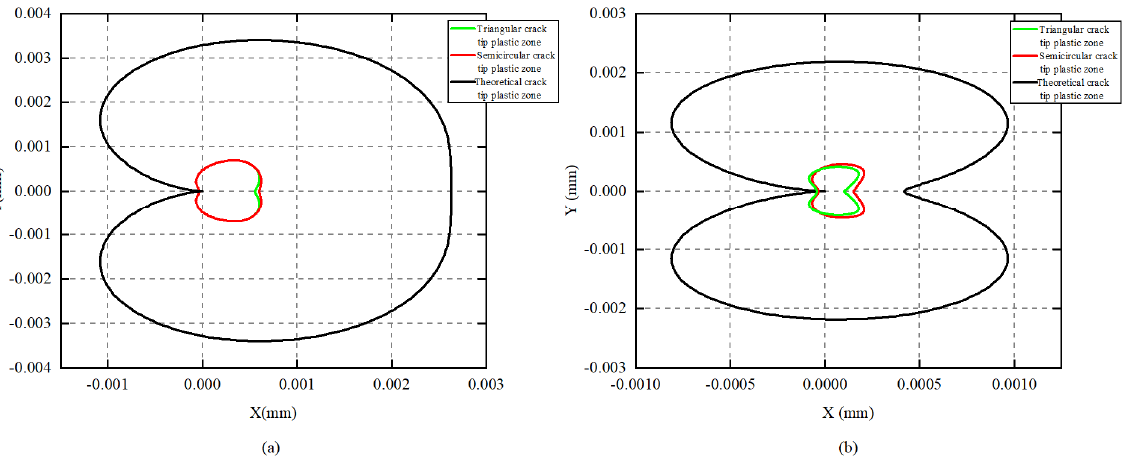
Figure 7. Comparison of ( a ) plastic zone under plane stress; ( b ) plastic zone under plane strain.